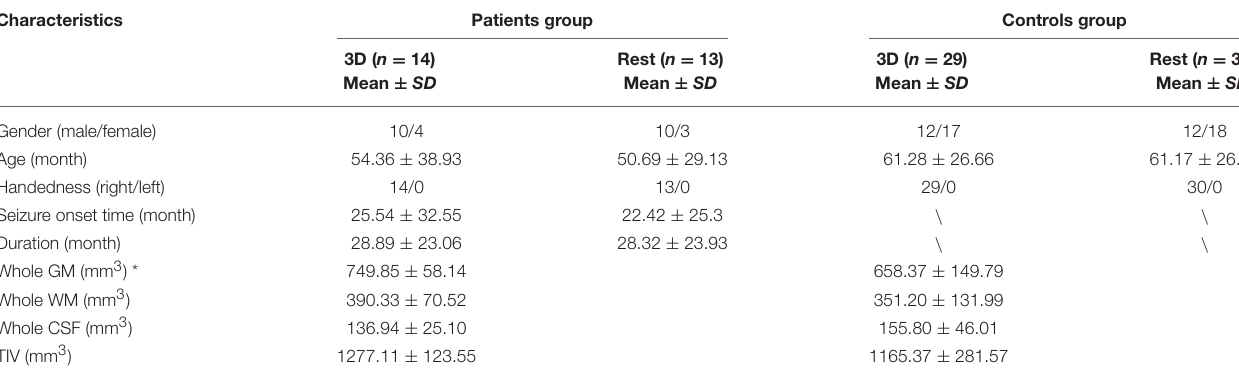
TABLE 1 | Demographic and clinical information data of the subjects.